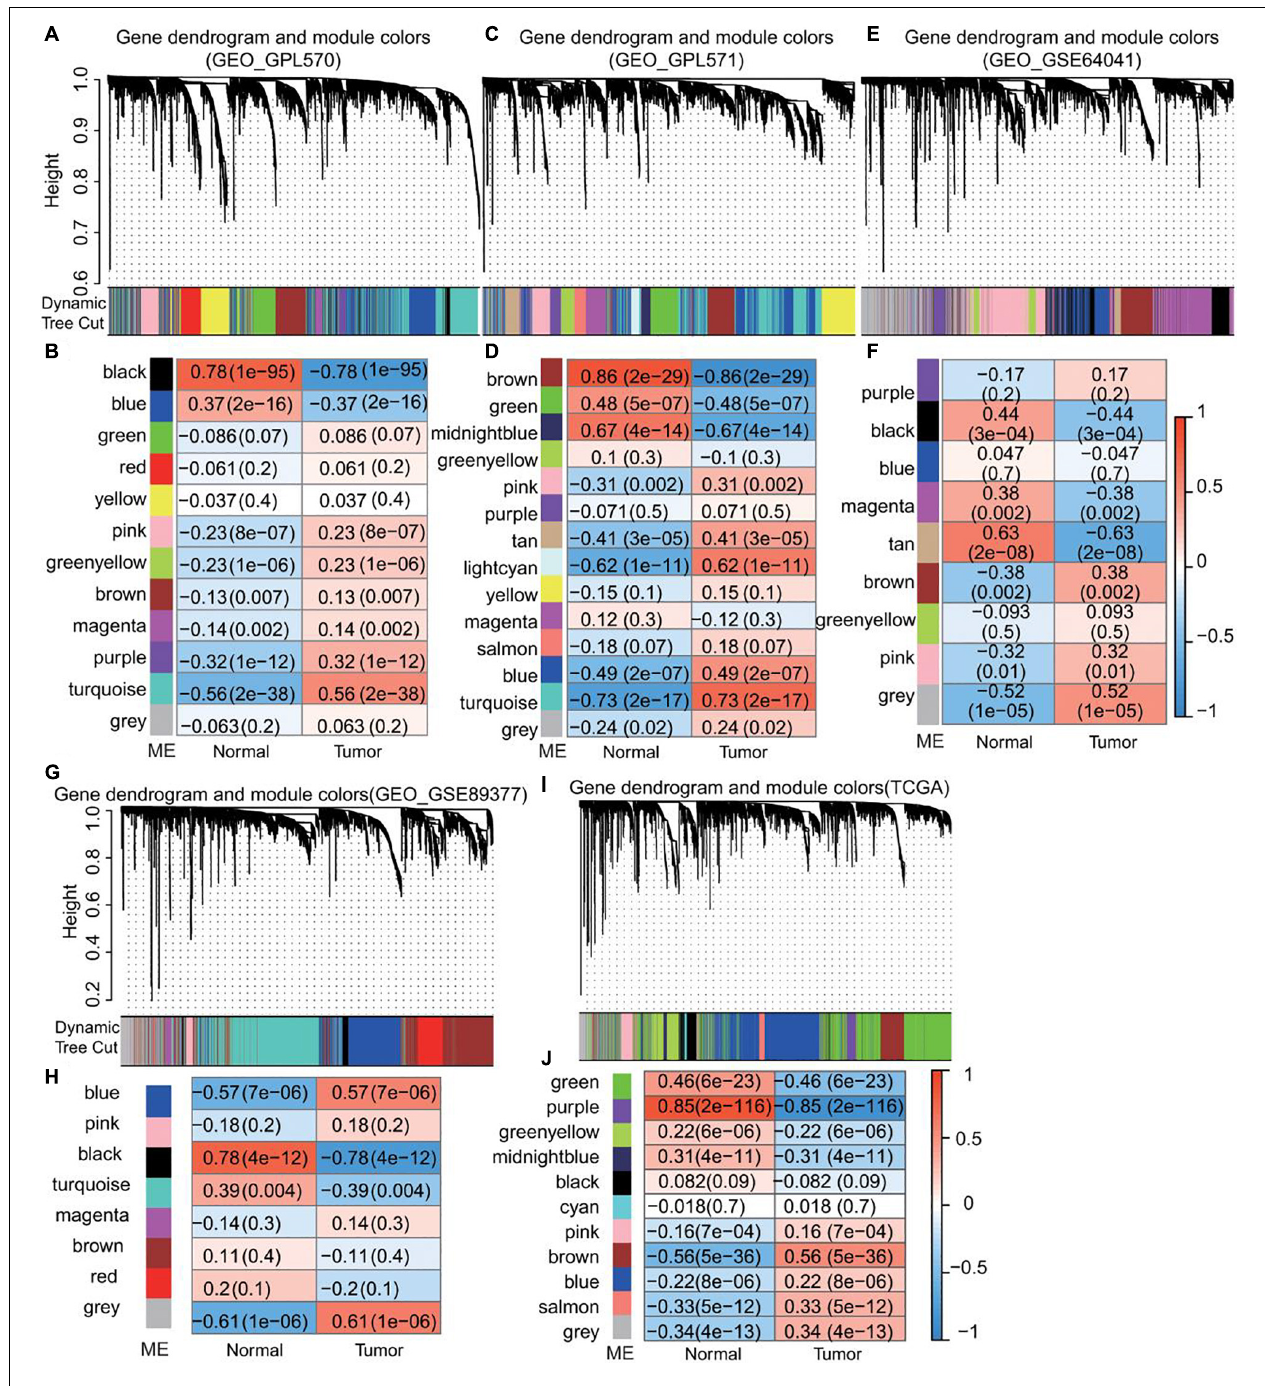
FIGURE 2 | Identification of module eigengenes (MEs) associated with HCC using GEO and TCGA datasets. (A , C , E , G , I) Dendrogram of DEGs clustered based on a dissimilarity measure (1–TOM). (B , D , F , H , J) Module-trait relationships. Each row corresponds to a color module and each column correlates to a clinical trait (normal and cancer). The numbers in each cell represent the corresponding correlation and P -value.